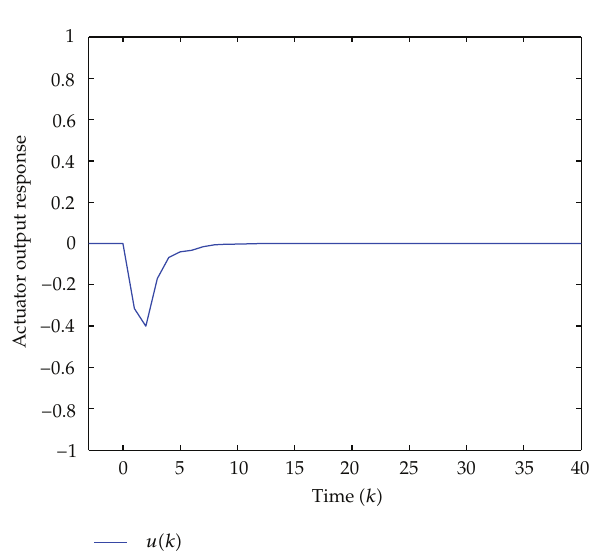
Figure 3: The actuator output under saturated